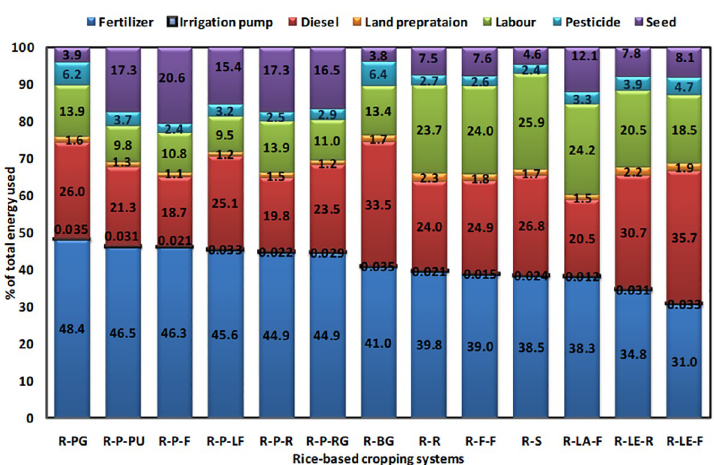
Fig 5. Percent energy used from different farm inputs for different rice-based cropping systems. [here, R-PG: rice- pointed gourd, R-P-PU: rice-potato-pumpkin, R-P-F: rice-potato-fallow, R-P-LF: rice-potato-ladies finger, R-P-R: rice-potato-rice, R-P-RG: rice-potato-ridge gourd, R-BG: rice-bitter gourd, R-R: rice-rice, R-F-F: rice-fallow-fallow, R-S: rice-sunflower, R-LA-F: rice-lathyrus-fallow, R-LE-R: rice-lentil-rice, R-LE-F: